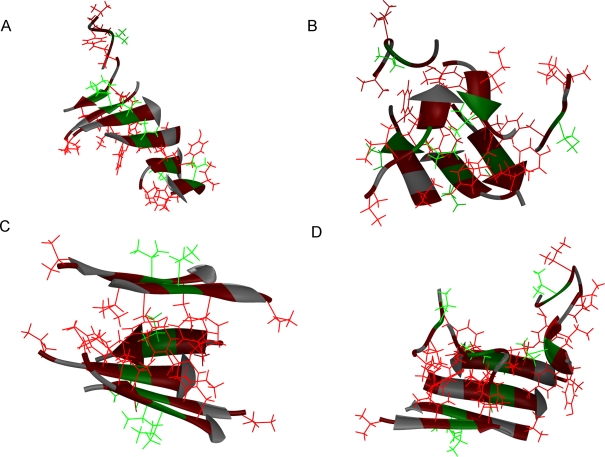
Snapshots of four meta-stable aggregates seen in the pre-nucleation phase of the 12-chain run at low concentration (side length 80 Å).The snapshots were taken at steps 8, 12, 26, and 48, respectively, as indicated by arrows in Figure 1a. V1, I3 and Y5 side chains are colored red, V4 side chains are green, and Q2 and K6 sidechains are, for clarity, omitted. (a) A single β-sheet. (b) A relatively irregular aggregate with two small β-sheets. (c) A small β-sandwich composed of one four-stranded and one two-stranded sheet. (d) A small β-sheet in contact with four random coils.